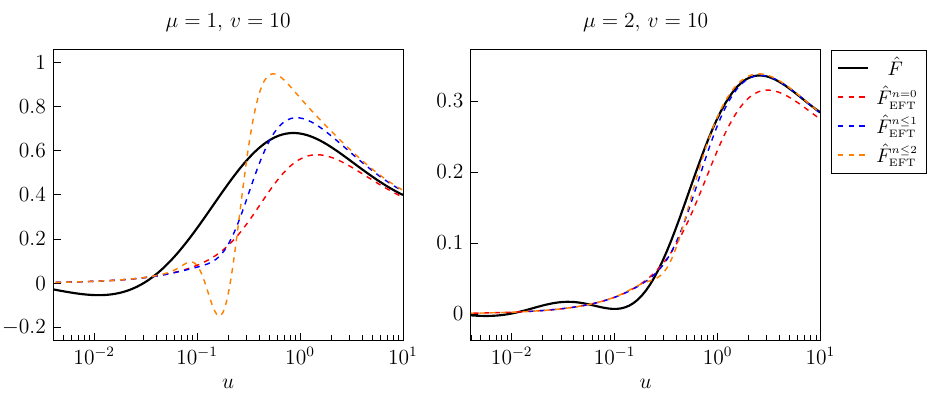
Figure 16 . In this figure, we contrast the four-point function computed by means of the non-local EFT namely ˆ F , with the full result ˆ F ( u, v ) . Here, ˆ F n ≤ m indicates the four-point function that EFT EFT comes out of summing over the first m + 1 operators in the action (6.24). Right : for a typical heavy particle with m/H ∼ O (1) , the non-local EFT prediction for u > 1 improves by including more higher (time) derivative terms in the action. In agreement with our analysis in section 6.1, adding more terms does not help the precision for u < 1 . That is where the dynamics of σ including the particle production effects and the associated oscillations become operative. Left : for masses that are close to 3 H/ 2 , including more terms in the action heightens the mismatch between the two results, signaling the divergence of the non-local EFT expansion with not so heavy intermediate